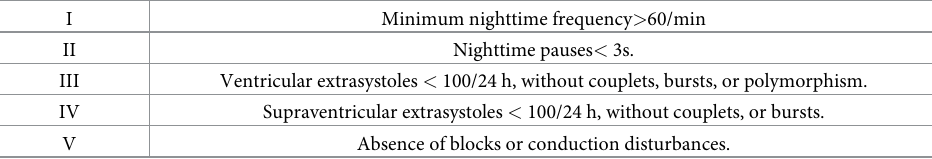
Table 1. Criteria of normality for all Holter records obtained in the present work.